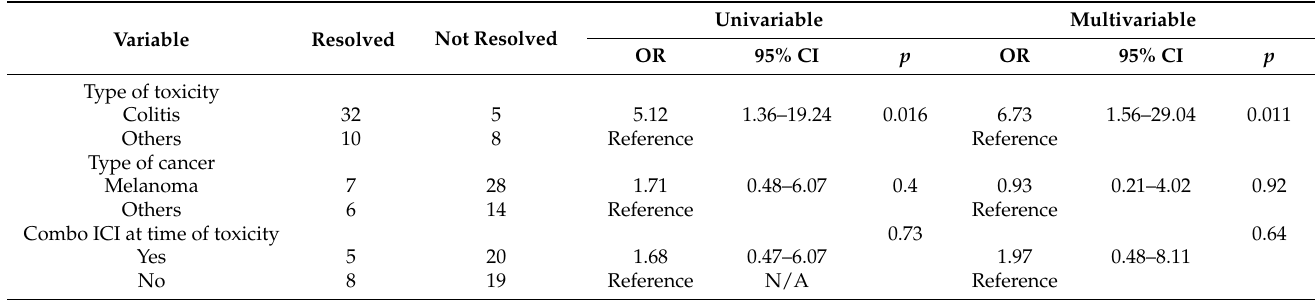
Table 2. Characteristics associated with the resolution of an irAE post-infliximab.